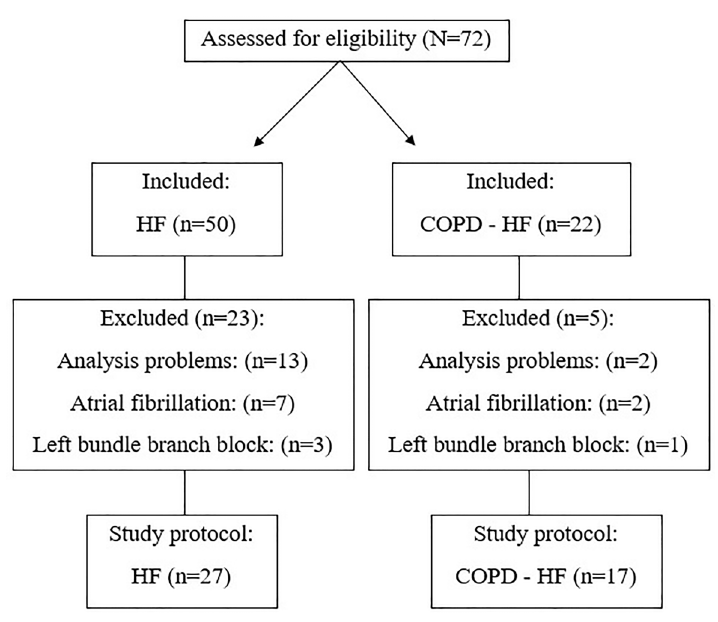
Figure 2. Flowchart of the study. HF: heart failure; COPD: chronic obstructive pulmonary disease.